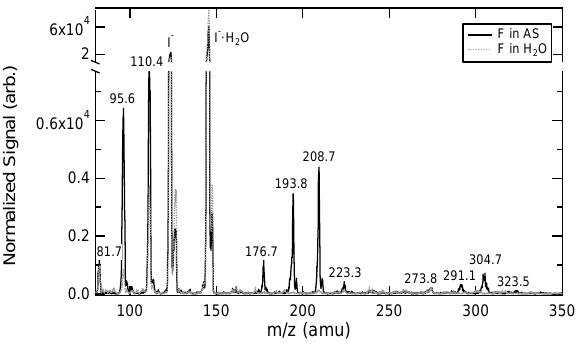
Figure 5. Aerosol-CIMS spectra of atomized solutions of 0.2 M formaldehyde in 3.1 Fig. 5. Aerosol-CIMS spectra of atomized solutions of 0.2M M AS and H 2 O. See the text for details of sample preparation and analysis. Negative- formaldehyde in 3.1MAS and H 2 O. See the text for details of sam- ple preparation and analysis. Negative-ion mass spectrum obtained ion mass spectrum obtained using I - as the reagent ion. using I − as the reagent ion.